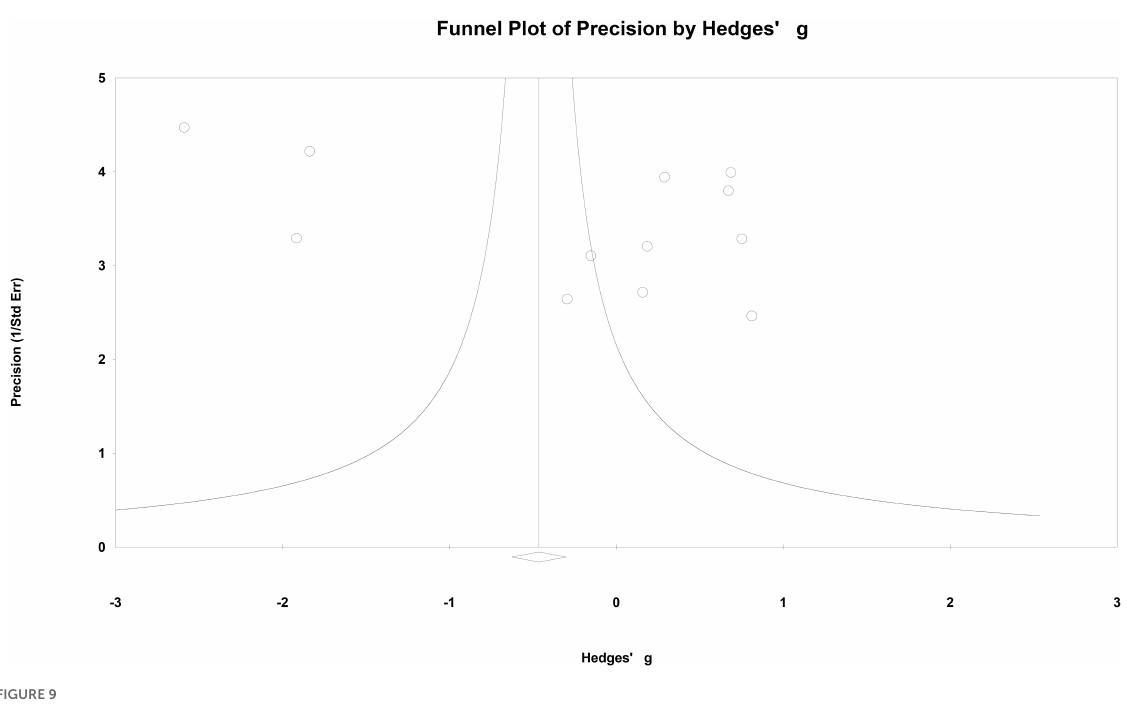
FIGURE9 Funnel plot of precision using Hedges’ g